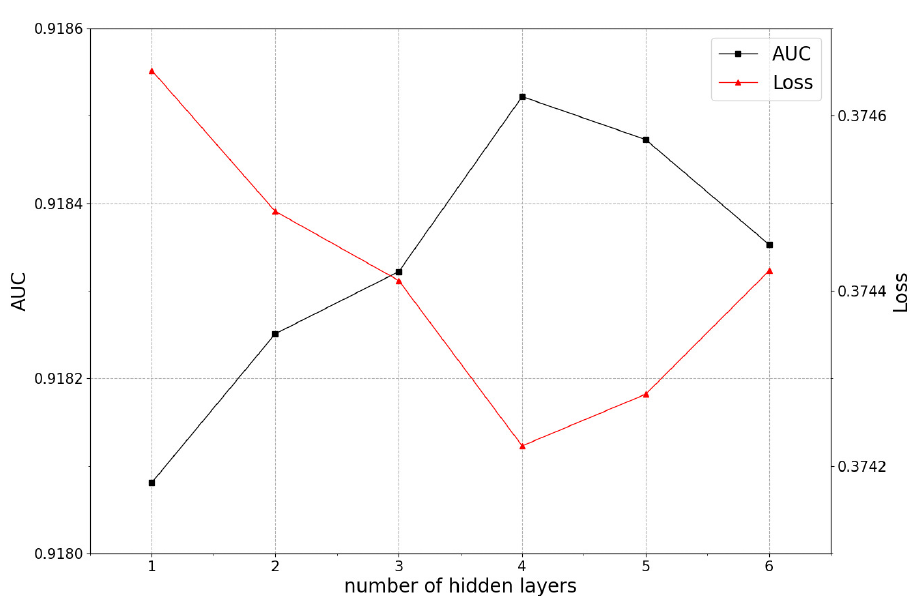
Figure 9. The impact of the number of hidden layers on model